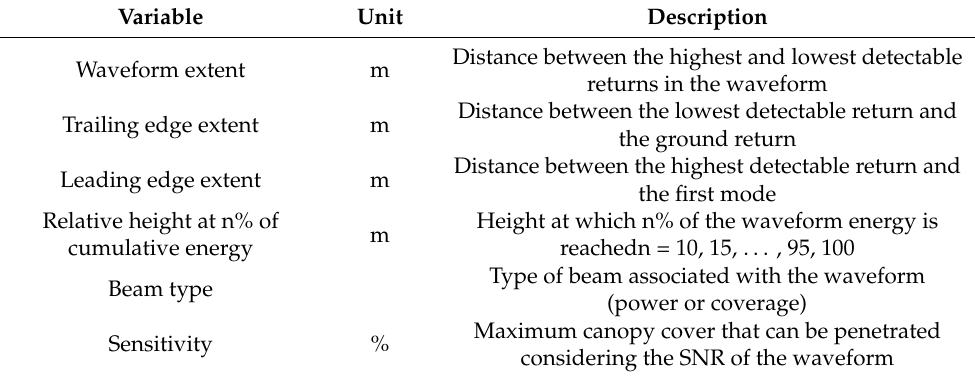
Table 2. GEDI L2A variables to be used as predictors in the canopy height regression models. Variable Unit Description Distance between the highest and lowest detectable Waveform extent m returns in the waveform Distance between the lowest detectable return and Trailing edge extent m the ground return Distance between the highest detectable return and Leading edge extent m the first mode Relative height at n% of Height at which n% of the waveform energy is m cumulative energy reachedn = 10, 15, . . . , 95, 100 Type of beam associated with the waveform Beam type (power or coverage)